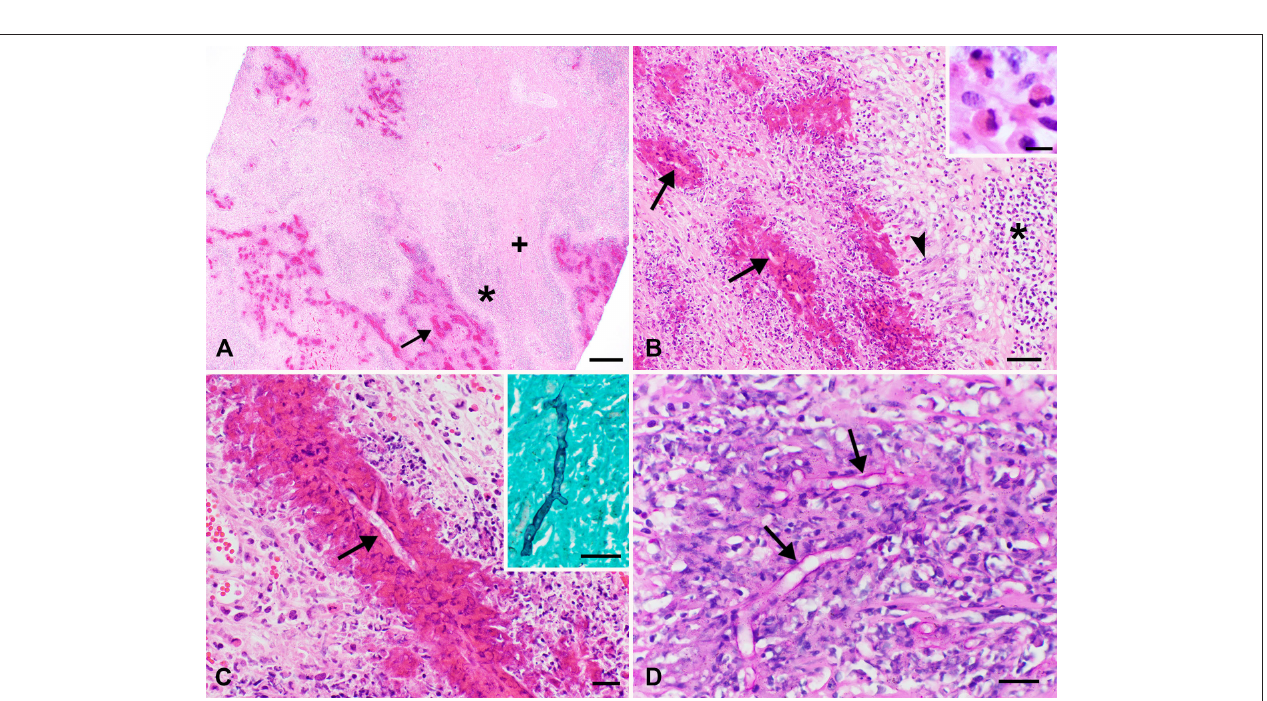
FIGURE 2 | Photomicrographs of sections of lung obtained from the pig in Figure 1 . (A,B) The pulmonary parenchyma is largely effaced by multifocal to coalescing granulomas centered around non-staining hyphae highlighted by bright eosinophilic “sleeves” of Splendore-Hoeppli material (arrows) with degranulating and intact eosinophils (highlighted in the inset). Surrounding this is a layer of multinucleated giant cells and epithelioid macrophages (arrowhead), which are bordered by a thick band of lymphocytes and plasma cells (*). Coalescing between these granulomas is abundant dense fibrous stroma ( + ). H&E stain; bar = 500 µ m (A) , 50 µ m (B) , 10 µ m (B inset) . (C) Higher magnification view showing 7–14 µ m diameter, non-staining hyphae (arrow) with occasional non-dichotomous branching highlighted by brightly eosinophilic sleeves. H&E stain; bar = 20 µ m. The inset illustrates positive staining of hyphae with GMS. Bar = 20 µ m. (D) Hyphae (arrows) also stain weakly positive with PAS, which illustrates the infrequent septation and non-parallel walls of these hyphae. Bar = 20 µ